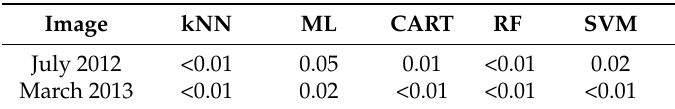
Table 7. McNemar test results ( p -values) for pair-wise comparison between pixel-based and object-based